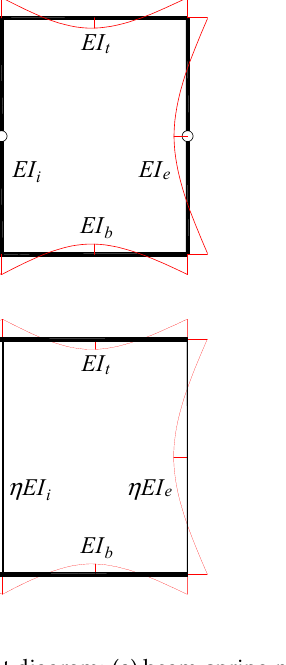
accordingly based on the equilibrium of moments at the ends.